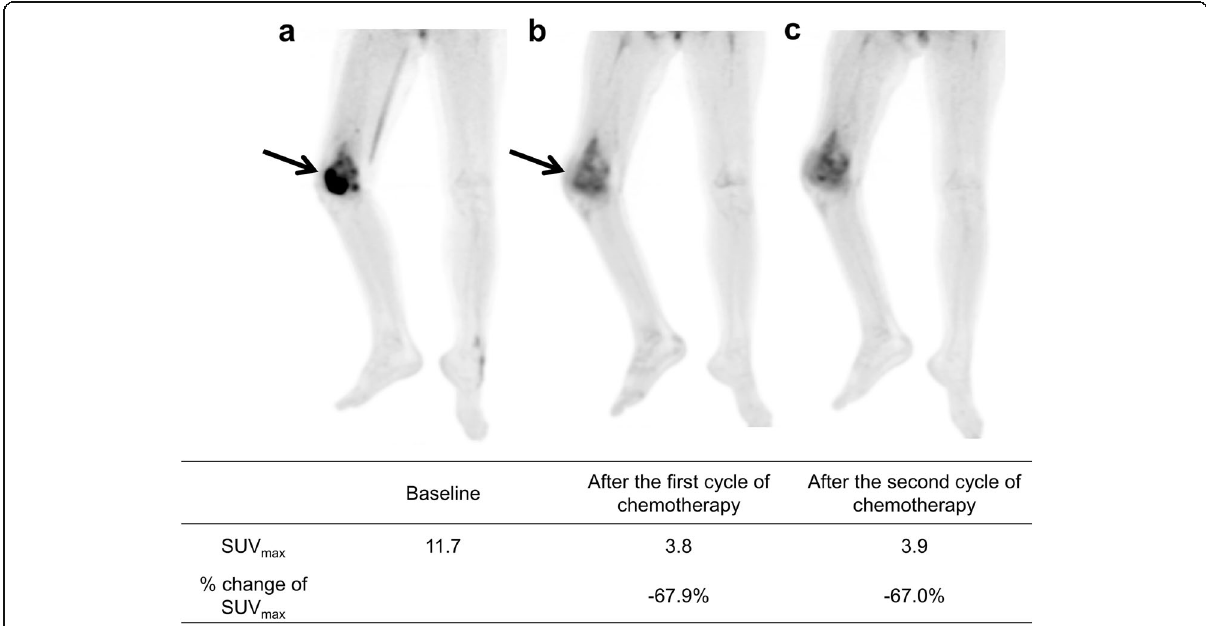
Fig. 4 Maximum intensity projection images of [ 18 F]FDG PET on the baseline ( a ), after the first cycle of neoadjuvant chemotherapy ( b ), and after the second cycles of neoadjuvant chemotherapy ( c ) of a 12-year-old female with osteosarcoma of the right femur. After neoadjuvant chemotherapy, SUV max has reduced by 67.9% and 67.0% after 1 cycle and 2 cycles of neoadjuvant chemotherapy, respectively. Although the patient showed a poor histologic response to neoadjuvant chemotherapy, the patient is alive without recurrence for 112 months after